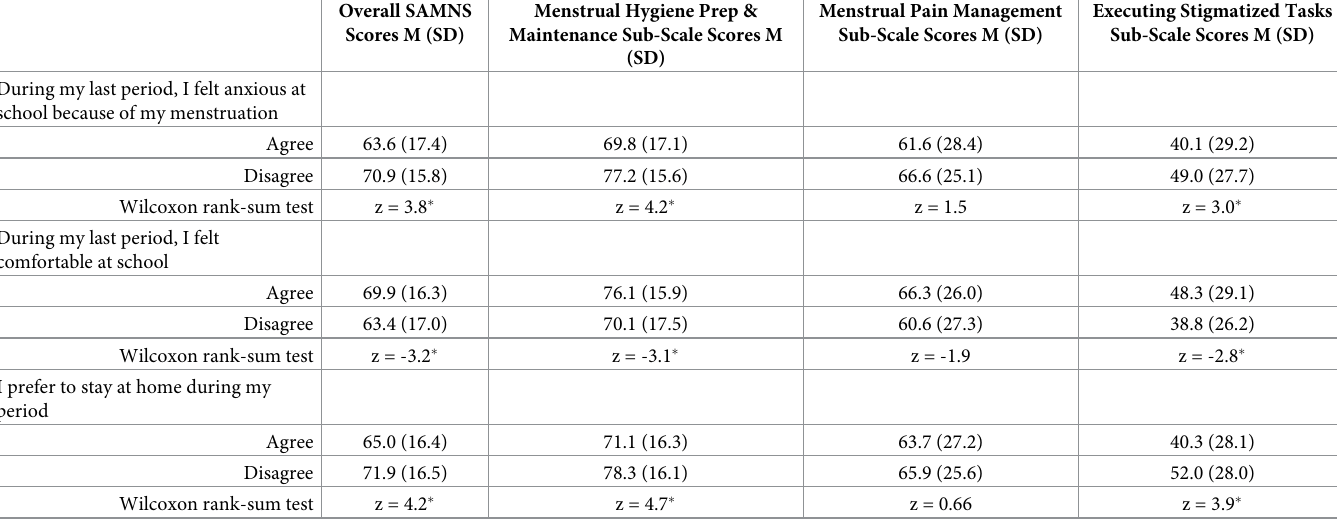
Table 8. Mean Self-Efficacy in Addressing Menstrual Needs Scale (SAMNS) scores by responses to validation items (n =